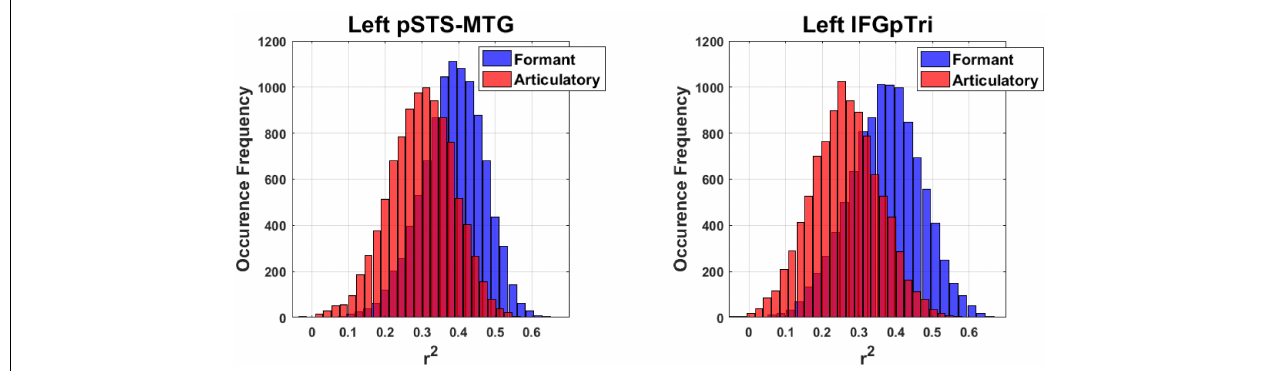
FIGURE 4 | Bootstrap-based performance comparison between the articulatory and formant models, in regions surviving Bonferroni correction (C.I.: 5–95th of the distribution obtained by computing their